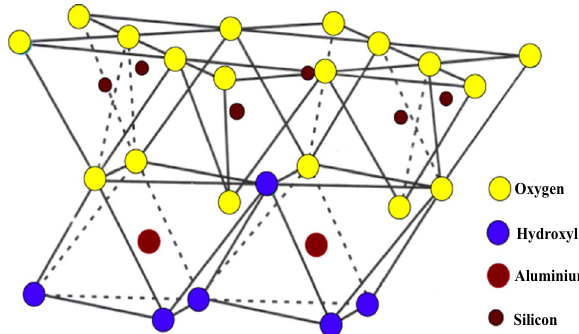
Fig. 16 Structure of